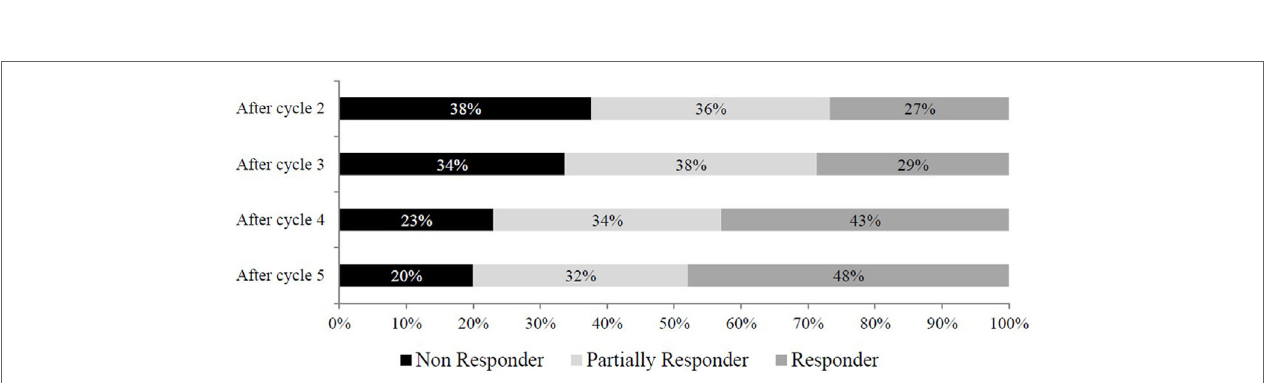
FigUre 1 | Evolution of Headache Impact Test-6 (HIT-6) scores and medication overuse with treatment cycles. Results are presented as percentages of patients with HIT-6 ≥ 60, patients with medication overuse and patients obtaining a reduction higher than 5 points from previous HIT-6 score. Fischer Exact test was used for testing distribution of data. Comparing values in each cycle with the previous cycle, significant improvement ( p < 0.05) was found for all items considered. Raw data in Table S1 in Supplementary